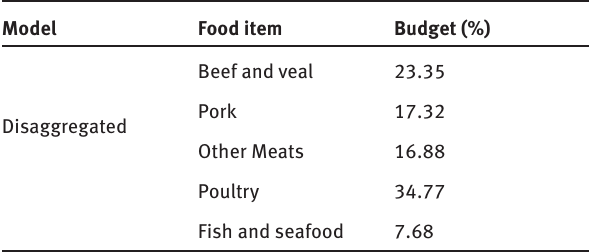
Table 1: Allocation of monthly protein budget among different food item (average 1995-2016)